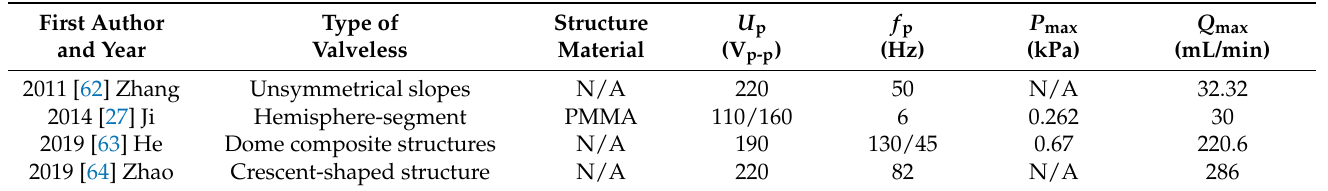
Table 4. Summary of properties for the valveless piezoelectric pump with built-in